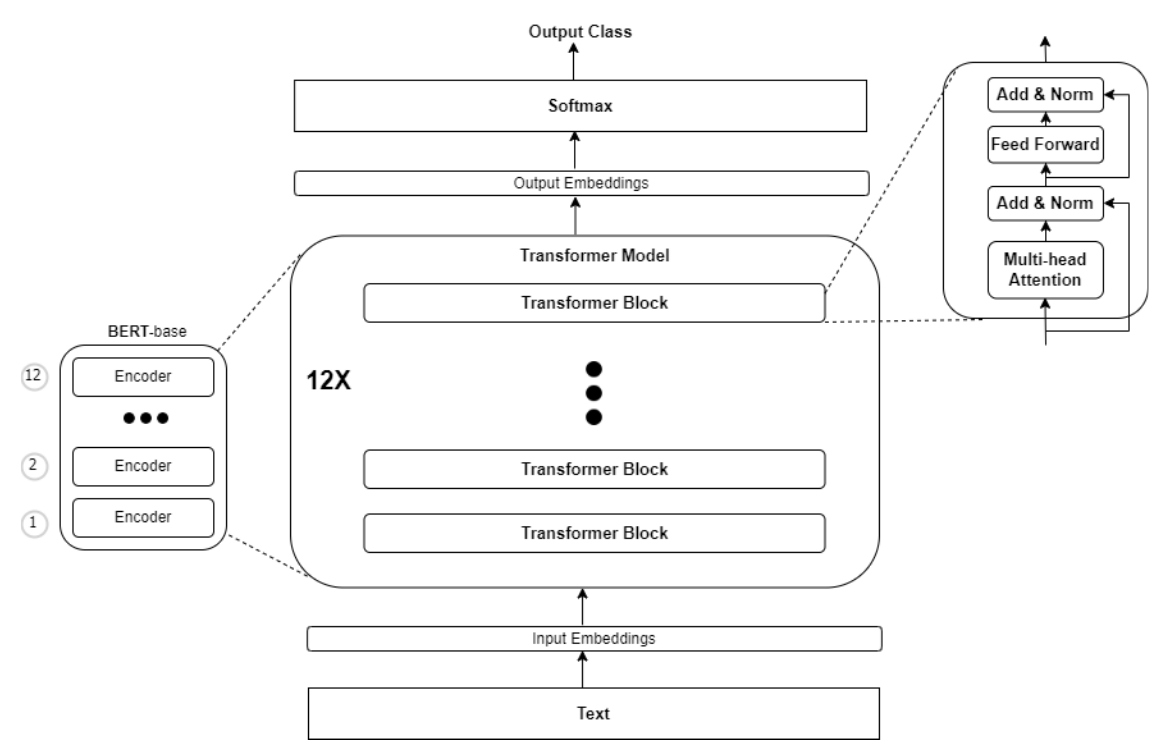
Figure 3. BERT-base architecture